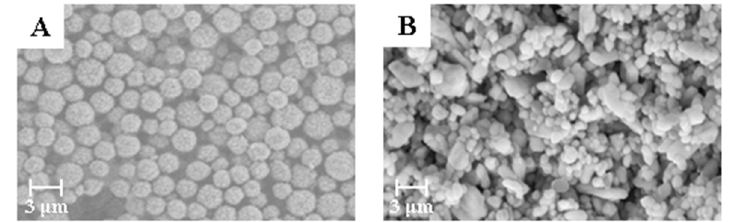
Figure 2. Scanning electron microscope (SEM) micrographs of BaSO 4 bifunctional sheets with different BaSO 4 morphology: ( A ) BaSO 4 microspheres; ( B ) amorphous BaSO 4 .